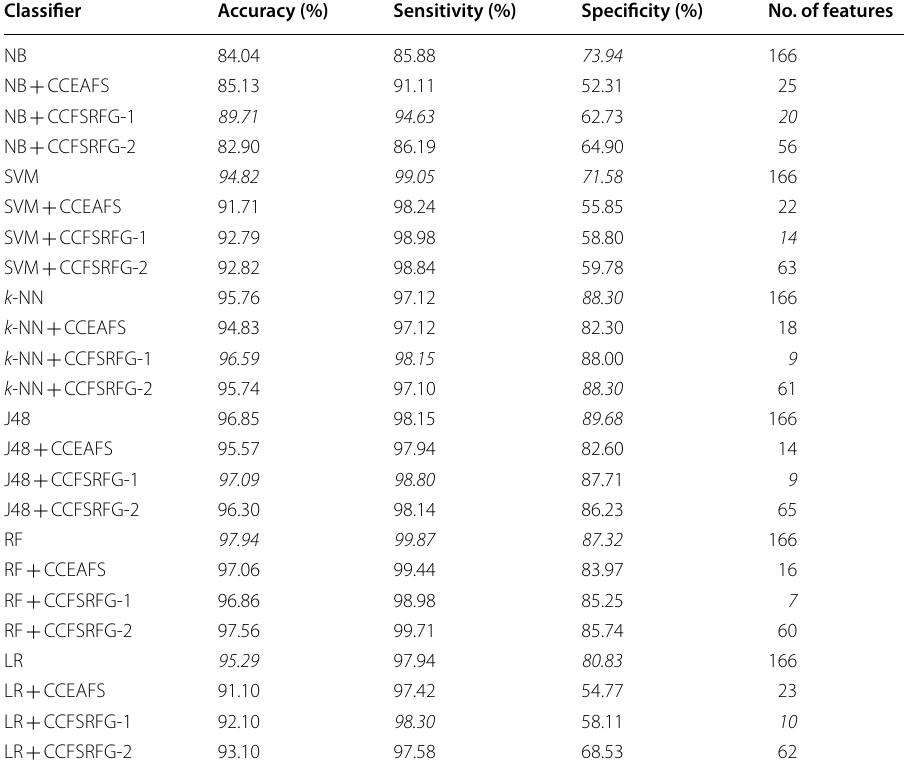
Italic signifies the improvements of the proposed approach over existing